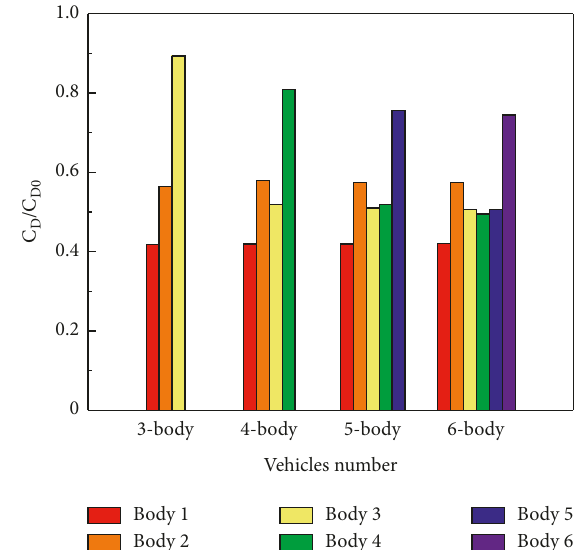
Figure 12: At x/(L) � 0.25, the comparison of the standardized drag coefficient C D /C D0 of each body in the different numbers of vehicles in the